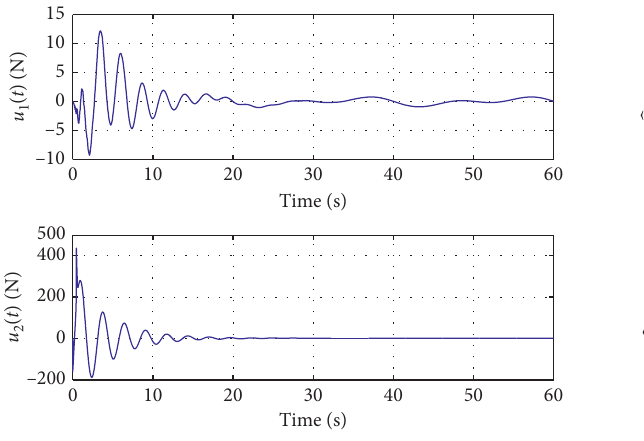
Figure 7: Control inputs.